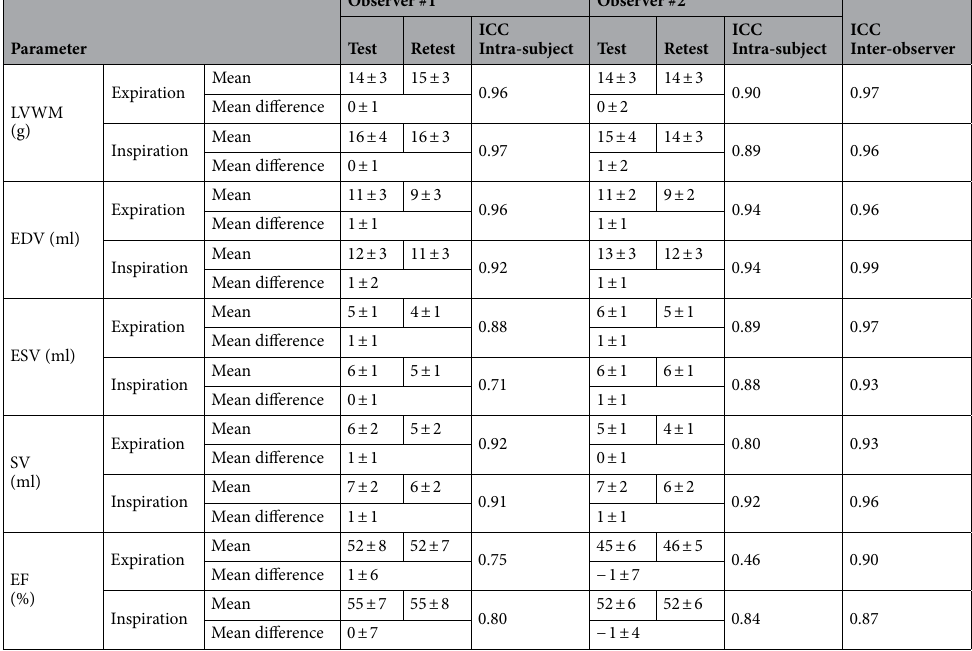
Table 2. Parameters of the left ventricular function assessed by Real-Time MRI. All data given as arithmetic mean and standard deviation (n = 10). Mean difference was defined as the individual differences between test and retest experiment. ICC: Intraclass Correlation Coefficient; LVWM: Left Ventricular Wall Mass; EDV: End- Diastolic Volume; ESV: End-Systolic Volume; SV: Stroke Volume; EF: Ejection Fraction.